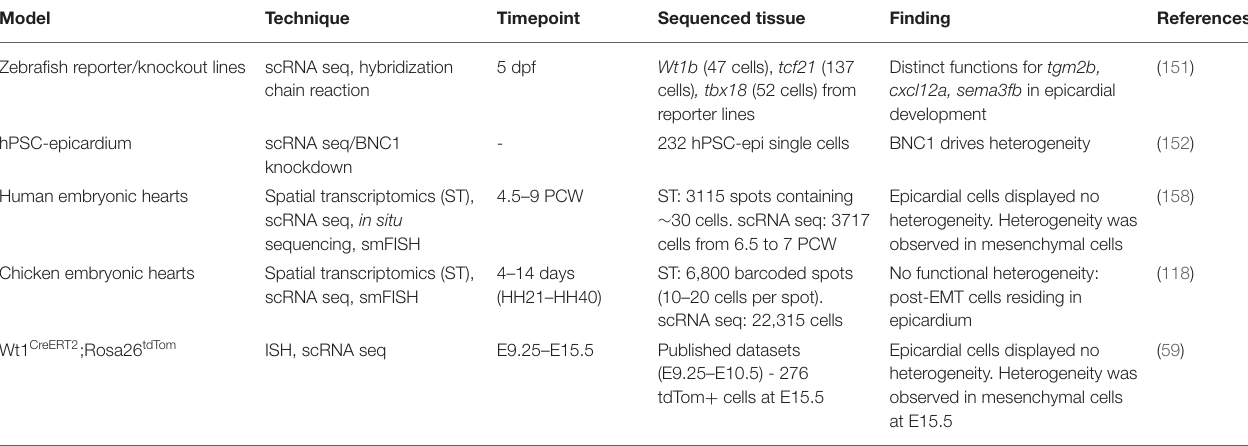
TABLE 1 | Overview of findings in search of heterogeneity in developing epicardium.